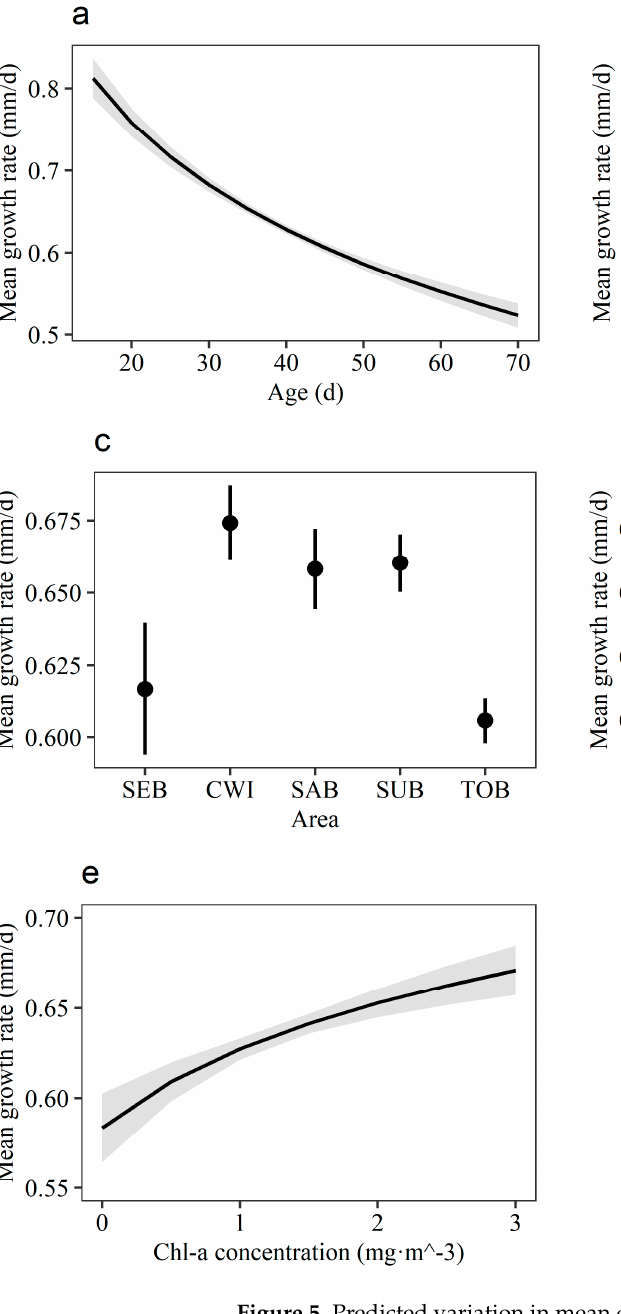
Figure 5. Predicted variation in mean daily growth rate of larval and juvenile Japanese anchovy in 2020–2021, back-transformed to the original scale. ( a ) Age-dependent trends (mean with 95% CI). ( b ) Relationship between mean growth rate and relative condition factor. ( c ) Fishing-area-specific variation in mean daily growth rate. ( d ) Relationship between mean growth rate and sea surface temperature. ( e ) Relationship between mean growth rate and chlorophyll-a concentration.